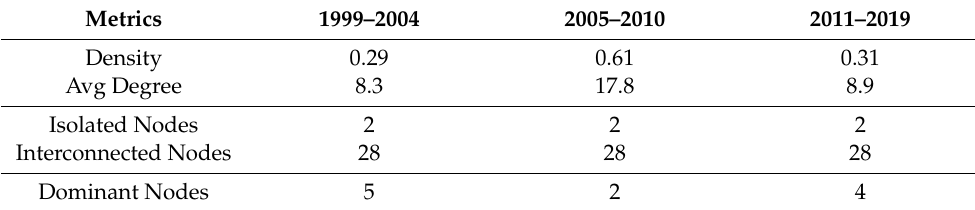
Table 10. Network metrics for 0.8 threshold level on the Debt (absolute values)